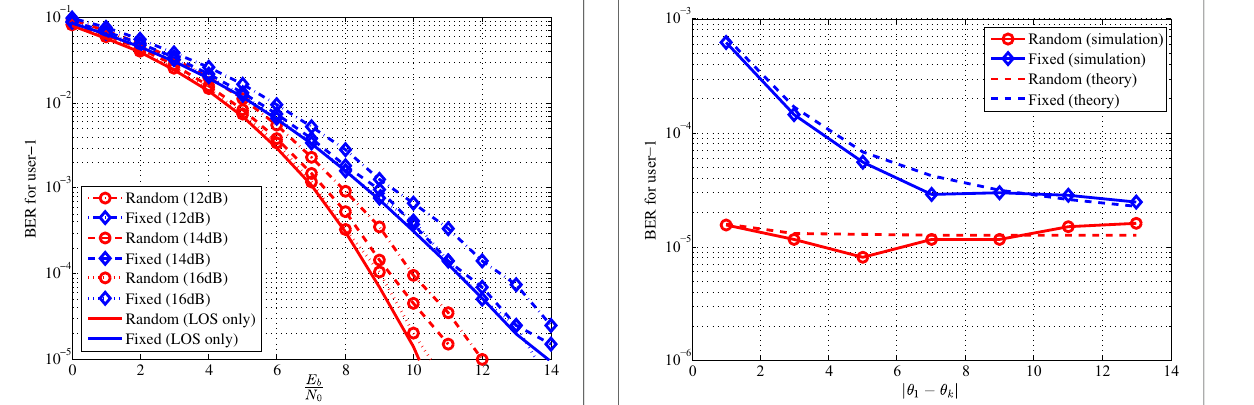
Fig. 11 BER for user-1 versus user distribution with UPA : M = 16, K = 14, E b / N 0 = 8 dB